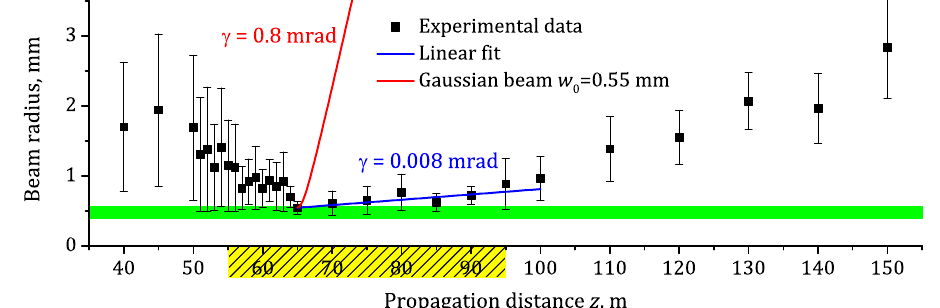
Figure 4. The dependence of the average beam radius on the distance z (squares) and its linear fit in the range z = 65–95 m (blue line). The green horizontal band shows the minimum value of the radius. Yellow rectangle is the range z = 55–95 m, where the beam propagates in postfilamentation regime. Radius of Gaussian beam at e − 1 with waist w 0 = 0.55 mm (red line) vs. z